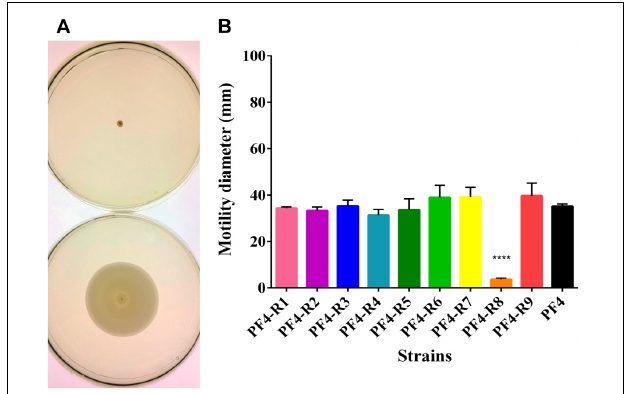
FIGURE 2 | Motility of V. anguillarum strains resistant to the CHOED phage. (A) Motility of resistant PF4-R8 strain (upper) and parental PF4 strain (lower). (B) Motility halo for each of the resistant strains. Tests were carried out in TSB medium supplemented with 0.4% agar and 2.3% NaCl. Cultures were incubated for 48 h at 25 ◦ C. Error bars represent standard deviation of triplicates. The results of the strain marked ( ∗∗∗∗ ) are significantly different from the parent strain ( p <